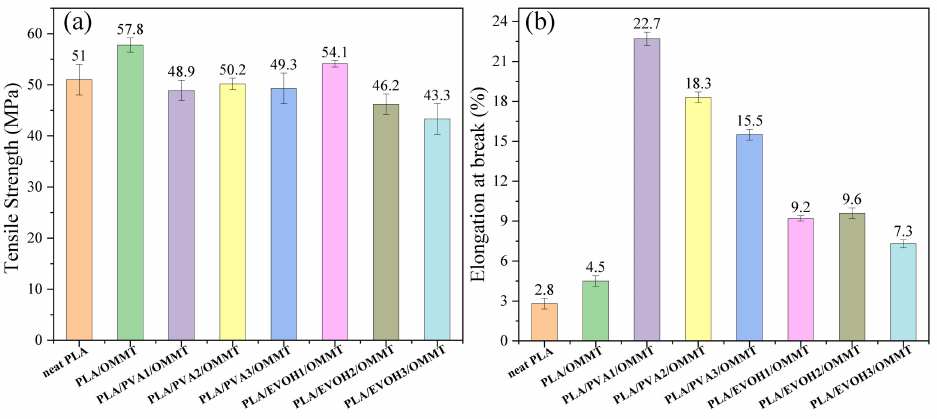
Figure 4. ( a ) Tensile strength and ( b ) elongation at break of PLA/PVA/OMMT and PLA/EVOH/OMMT composites.